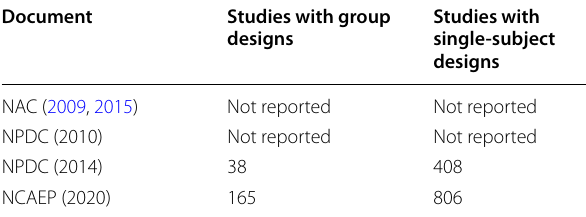
Table 4 Total number of studies with group and single-subject designs included in each review